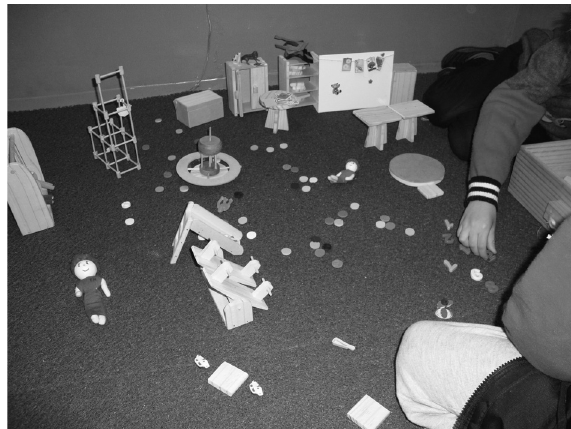
Figura 1 . Cenário Criado Pela Díade